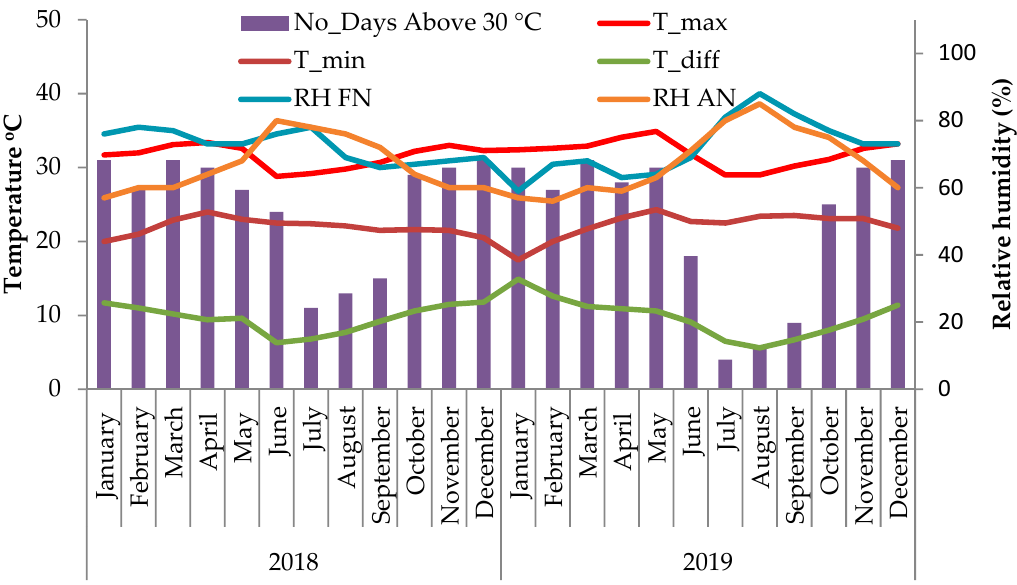
Figure 1. Fluctuations in monthly average maximum temperature (T max ), minimum temperature (T min ), difference between T max and T min (T_diff), days with T max greater than 30 °C and relative humidity % in the forenoon (RHFN) and afternoon (RHAN) during the experimental period for the years 2018 and 2019.